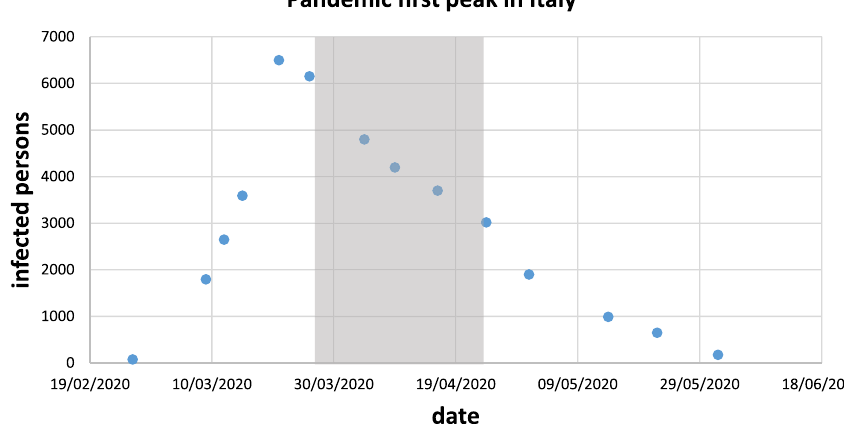
Figure 2. Peak verified in Italy during the first pandemic step. Dots: numbers of infected people per day. Light grey area: period of sound pressure level